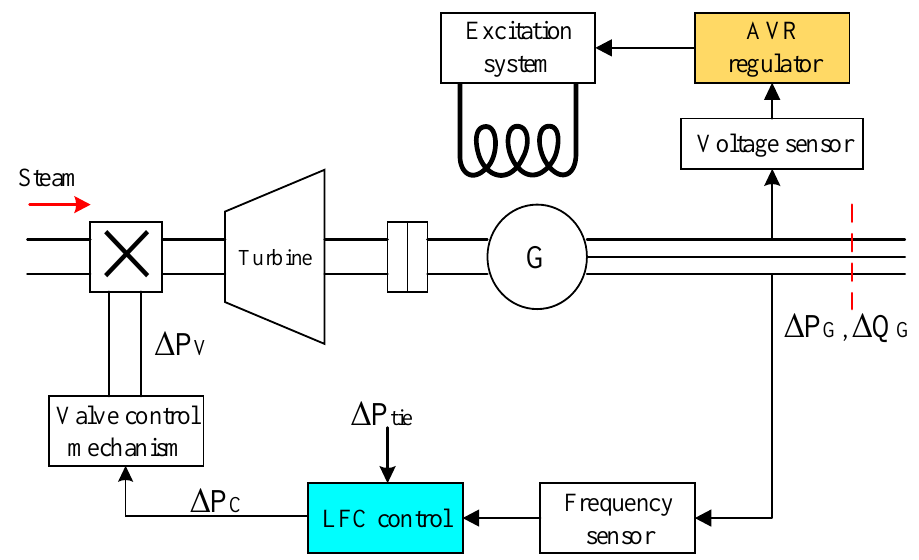
Figure 1. AVR and LFC loop of a synchronous generator.